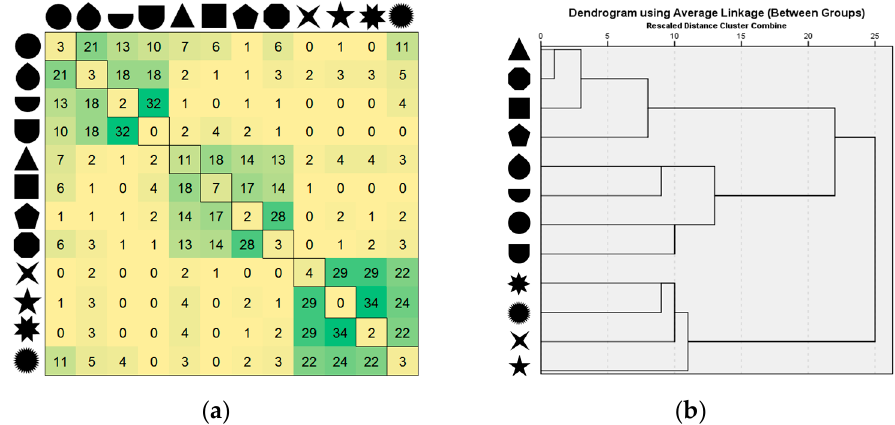
Figure 3. Co-occurrences of geometric shapes from free-sorting task 1, illustrated as ( a ) co-occurrence matrix: the values indicate the frequency counts of co-associations and those of single-item groups (see diagonal values) - higher values indicate higher similarity; and as ( b ) dendrogram based on agglomerative hierarchical cluster analysis.